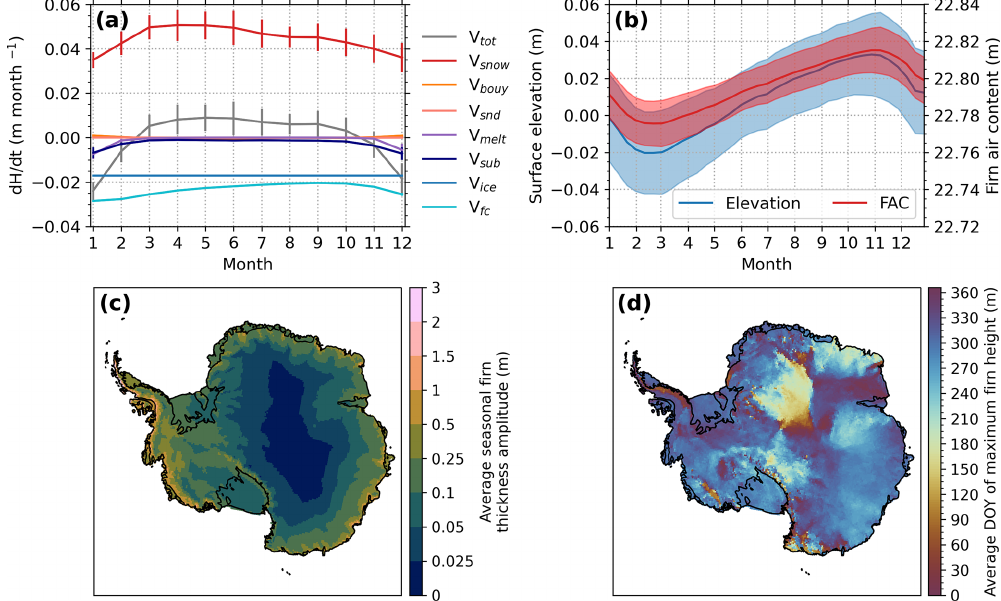
Figure 6. Ice-sheet-averaged seasonal cycle from FDM v1.2A of the (a) vertical firn surface velocity, including its separate components from Eq. (6), and of (b) surface elevation and firn air content (FAC). The bars and coloured areas indicate the interannual standard deviations. Maps from FDM v1.2A (c) of the average seasonal firn thickness amplitude and (d) of the average day of the year of the maximum firn